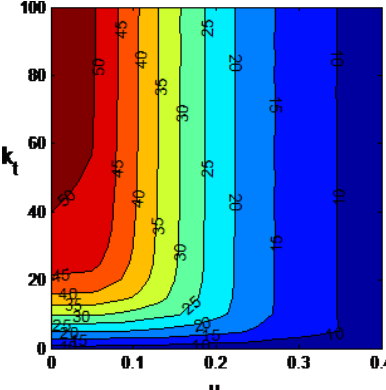
Figure 4. Contour plot of the buckling load p ( q = 0) with respect to µ and k r1 for k r0 = 10 8 (clamped at x = 0) and k t = 10 8 (no translation at x = L ).